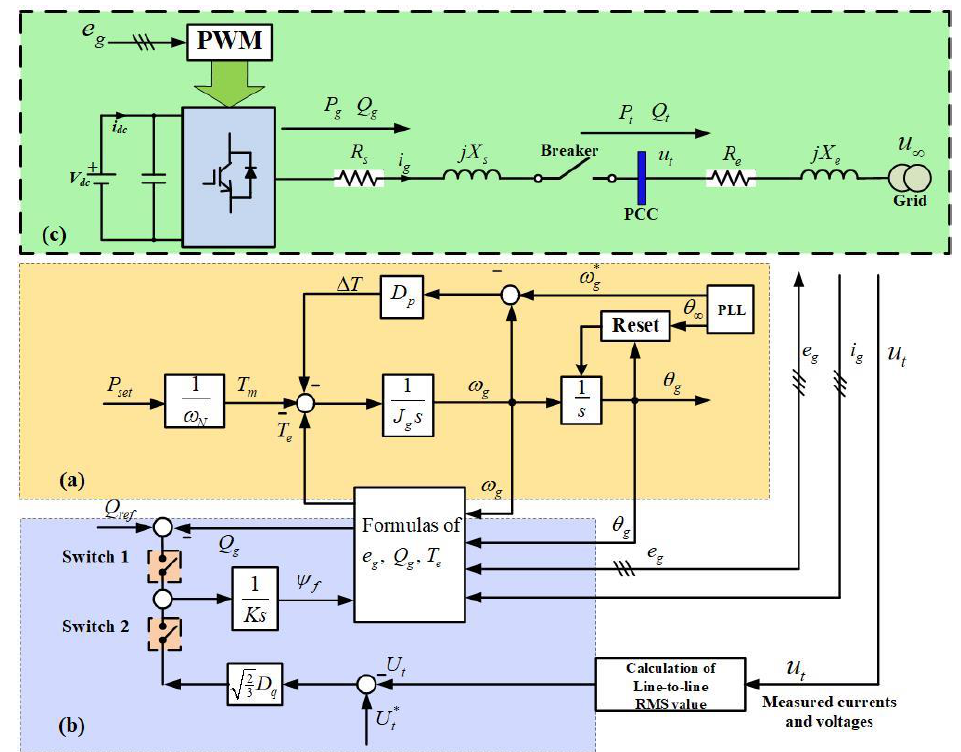
Figure 1. Schematic of the synchronverter main circuit, control system, and grid interface. ( a ) APL; ( b ) RPL; ( c ) power system of the synchronverter. ( b ) RPL; ( c ) power system of the